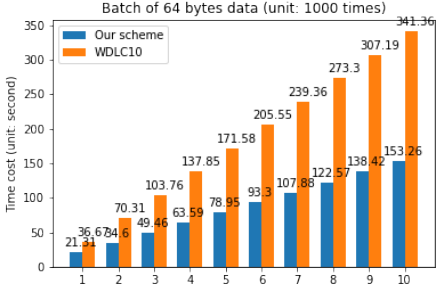
Figure 6. Time cost for our PRE scheme and WDLC10 encryption for every 1000 times of encryption of 64 bytes data on a 1st generation of Raspberry Pi model B 700